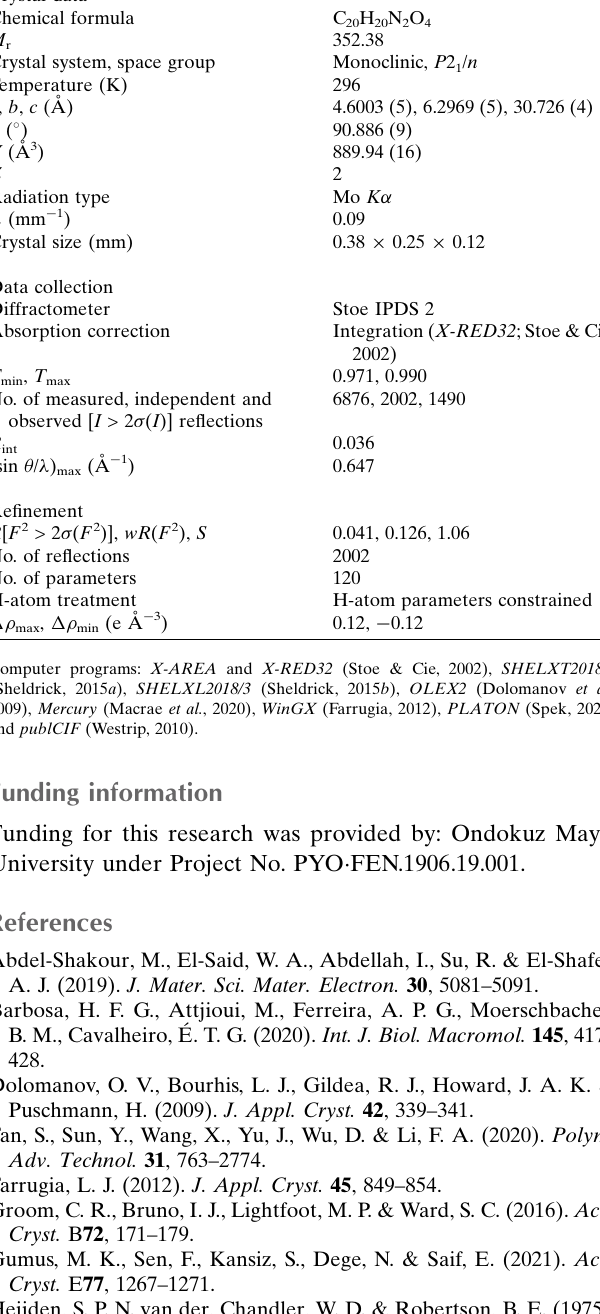
Table 3 Experimental details. Crystal data Chemical